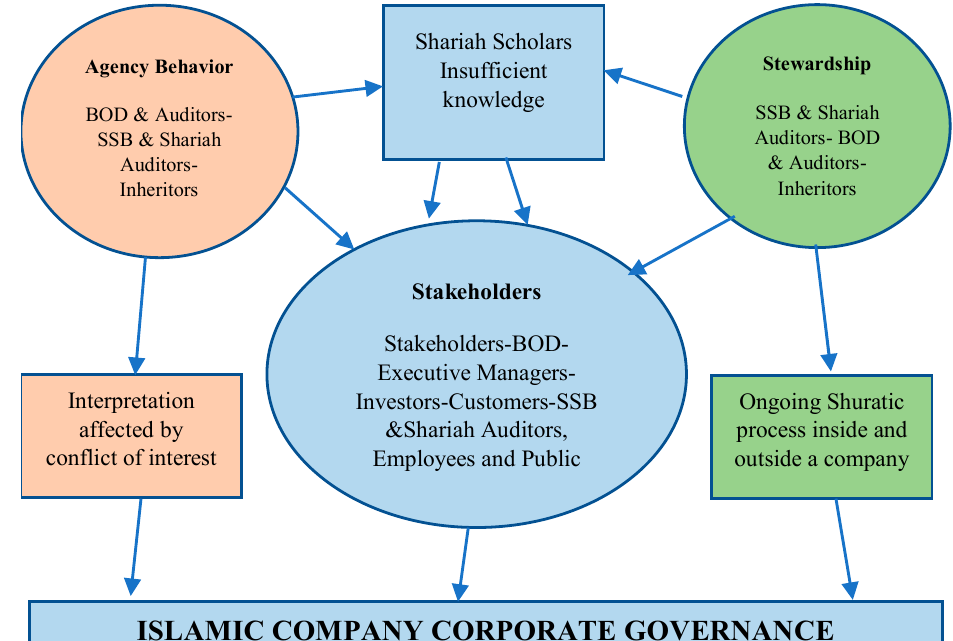
Figure 4. Corporate governance model for an Islamic company [71]. J. Open Innov. Technol. Mark. Complex. 2020 , 6 , x FOR PEER REVIEW